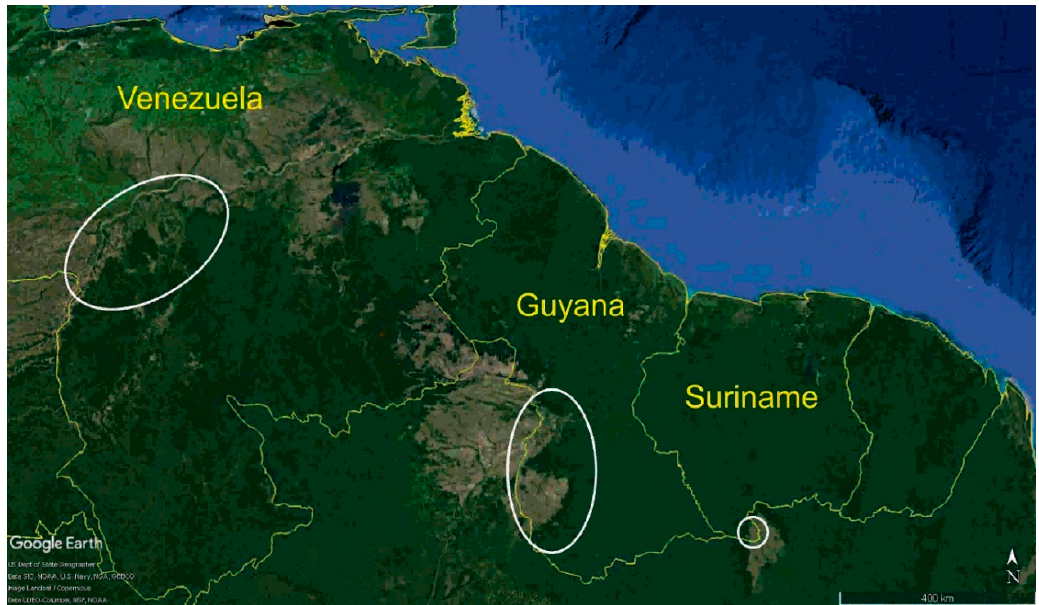
Figure 1. Map of the Guianas in northern South America with white outlines identifying the savanna study sites in Venezuela (Llanos), Guyana (Rupununi), and Suriname (Sipaliwini) that were surveyed for bats ©Burton K.